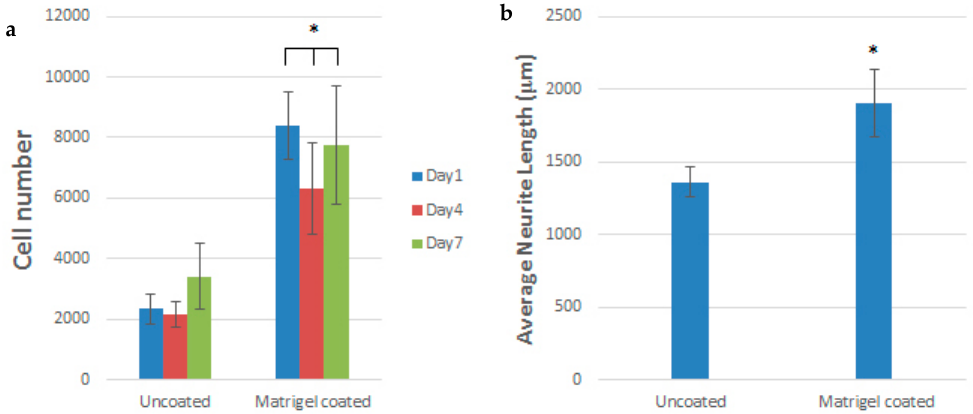
Figure 32. ( a ) SC number on aligned PVDF-TrFE fibrous scaffolds with or without Matrigel coating. Cell number on Matrigel coated scaffolds was significantly higher than on uncoated scaffolds at all time points (* p < 0.05). ( b ) Average neurite extension of DRGs cultured on uncoated and Matrigel coated PVDF-TrFE scaffolds. Neurite extension on Matrigel coated scaffolds was significantly higher than uncoated scaffolds (* p < 0.05). Reproduced from [194], published by Frontiers, 2018.